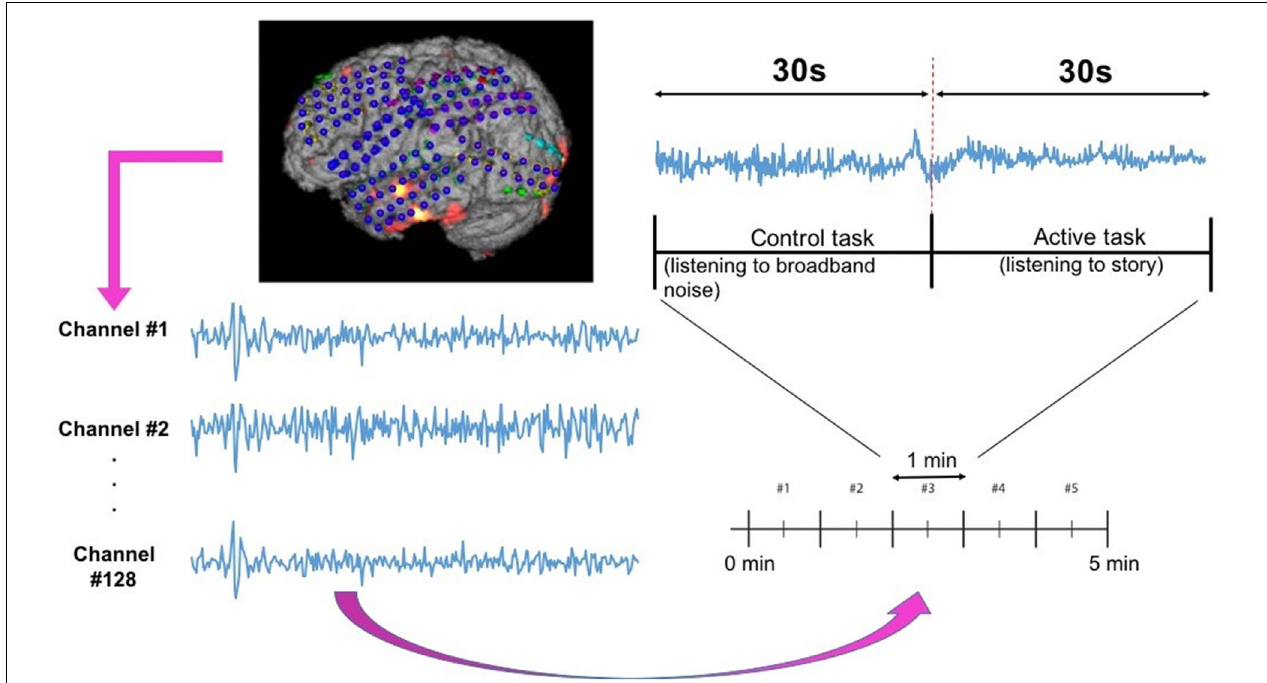
FIGURE 5 | Subdural grid localization and position of ECoG electrodes (128 of them) on the brain surface of individual patient are illustrated (left) . For a sample of 1 min language test, signals from both control and active tasks are illustrated (right)